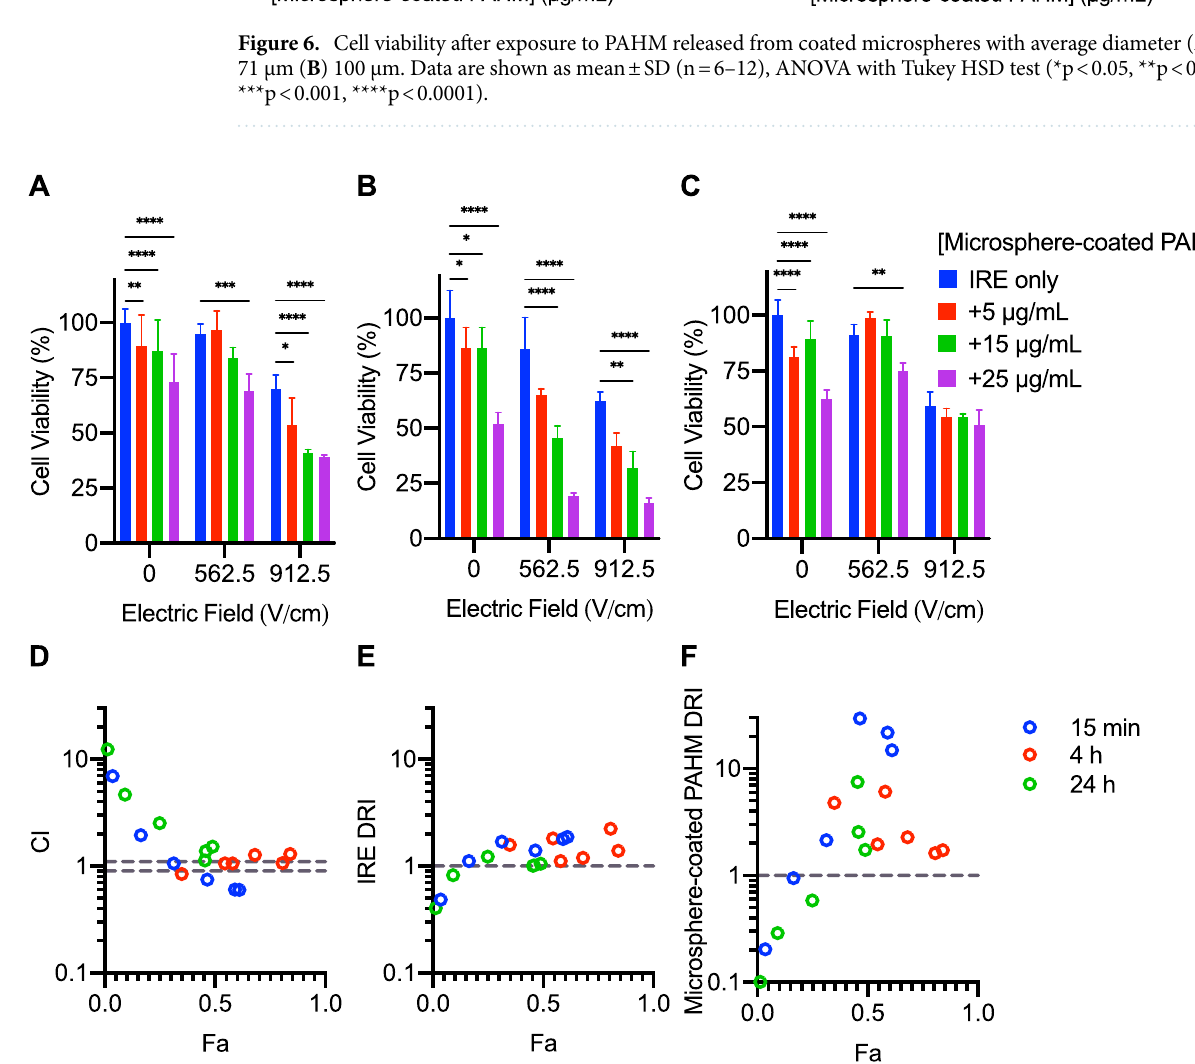
Figure 7. Cell viability after IRE treatment combined with exposure to PAHM released from coated embolic microspheres for ( A ) 15 min ( B ) 4 h ( C ) 24 h. Data are shown as mean ± SD (n = 3–9). ANOVA with Tukey HSD test (*p < 0.05, **p < 0.01, ***p < 0.001, ****p < 0.0001). ( D ) Combination index analysis (CI < 1, = 0.9–1 (dashed lines), > 1 indicates synergism, nearly additive effect, and antagonism, respectively). Dose reduction index analysis for ( E ) IRE and ( F ) microsphere-coated PAHM (DRI < 1, = 1 (dashed line), > 1 indicates unfavorable dose reduction, no dose reduction, favorable dose reduction,